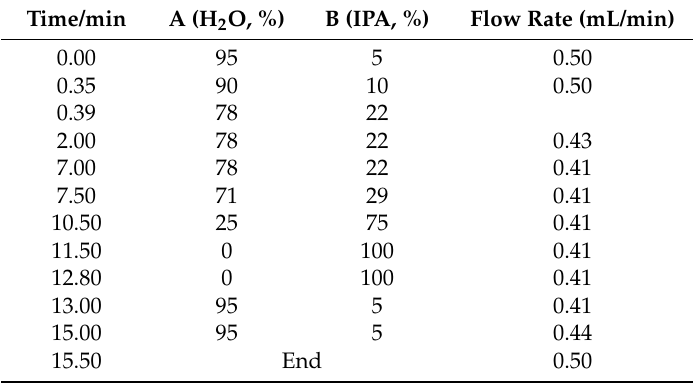
Table 1. Gradient UHPLC elution